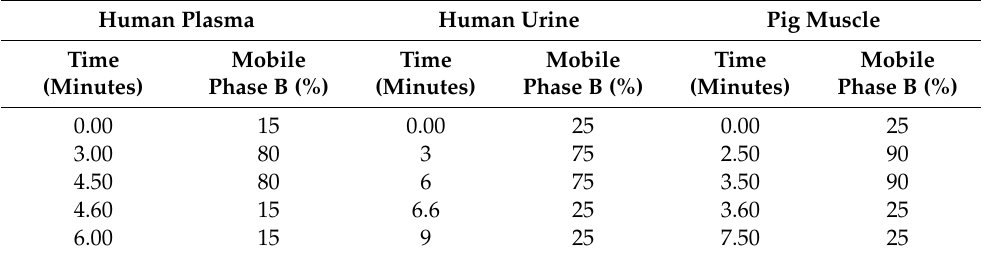
Table 5. Gradient program for HPLC method for human plasma, human urine and pig muscle analyses. Human